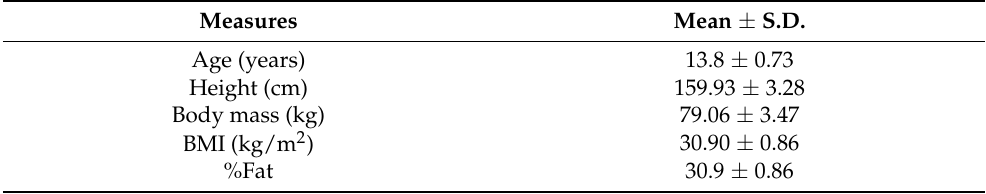
Table 1. The anthropometric characteristic of the participating